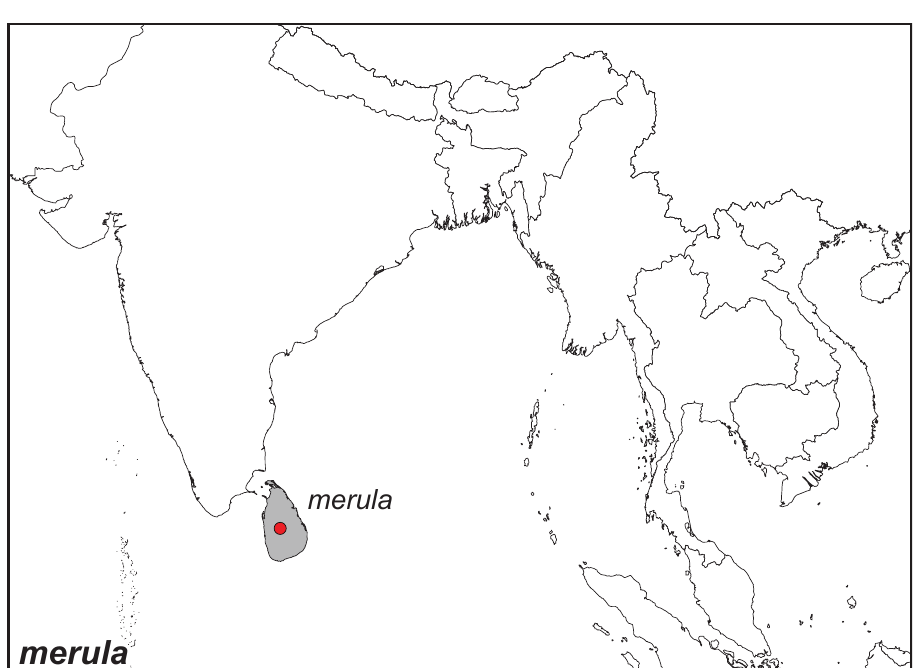
Figure 42. Distribution map of Elymnias merula